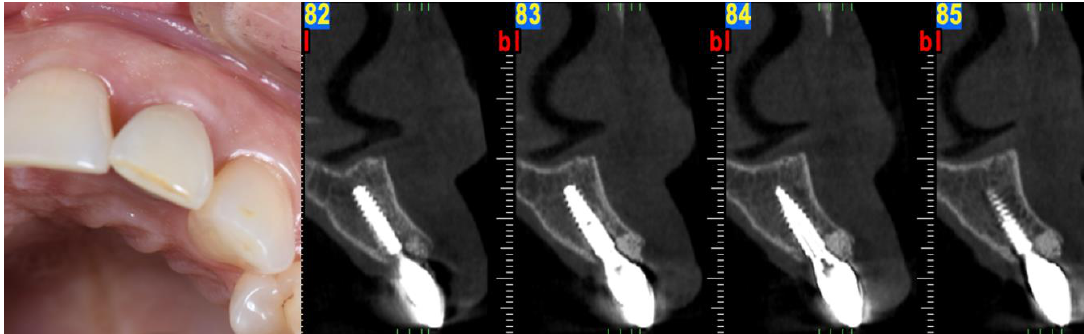
Figure 29. Clinical image and radiographic control. One year post loading.